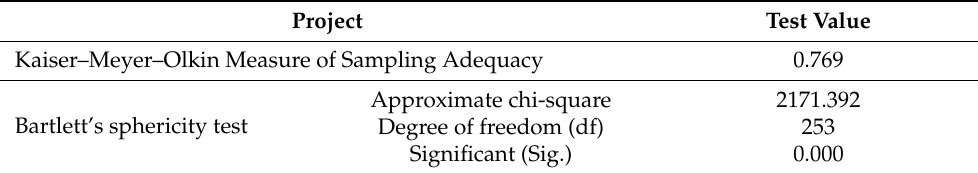
Table 3. Test results using KMO and Bartlett.